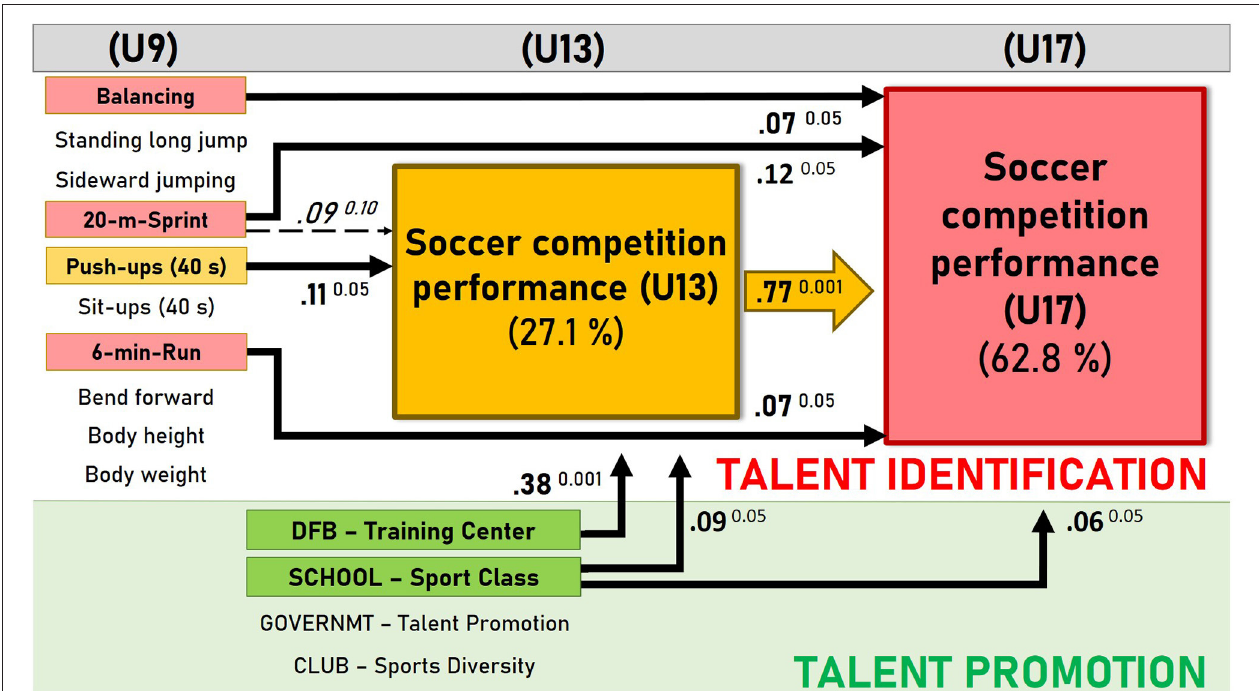
FIGURE 8 | Regression path analysis of early performance characteristics at U9 age and their relevance for midterm performance development in youth and adolescent soccer players ( N =